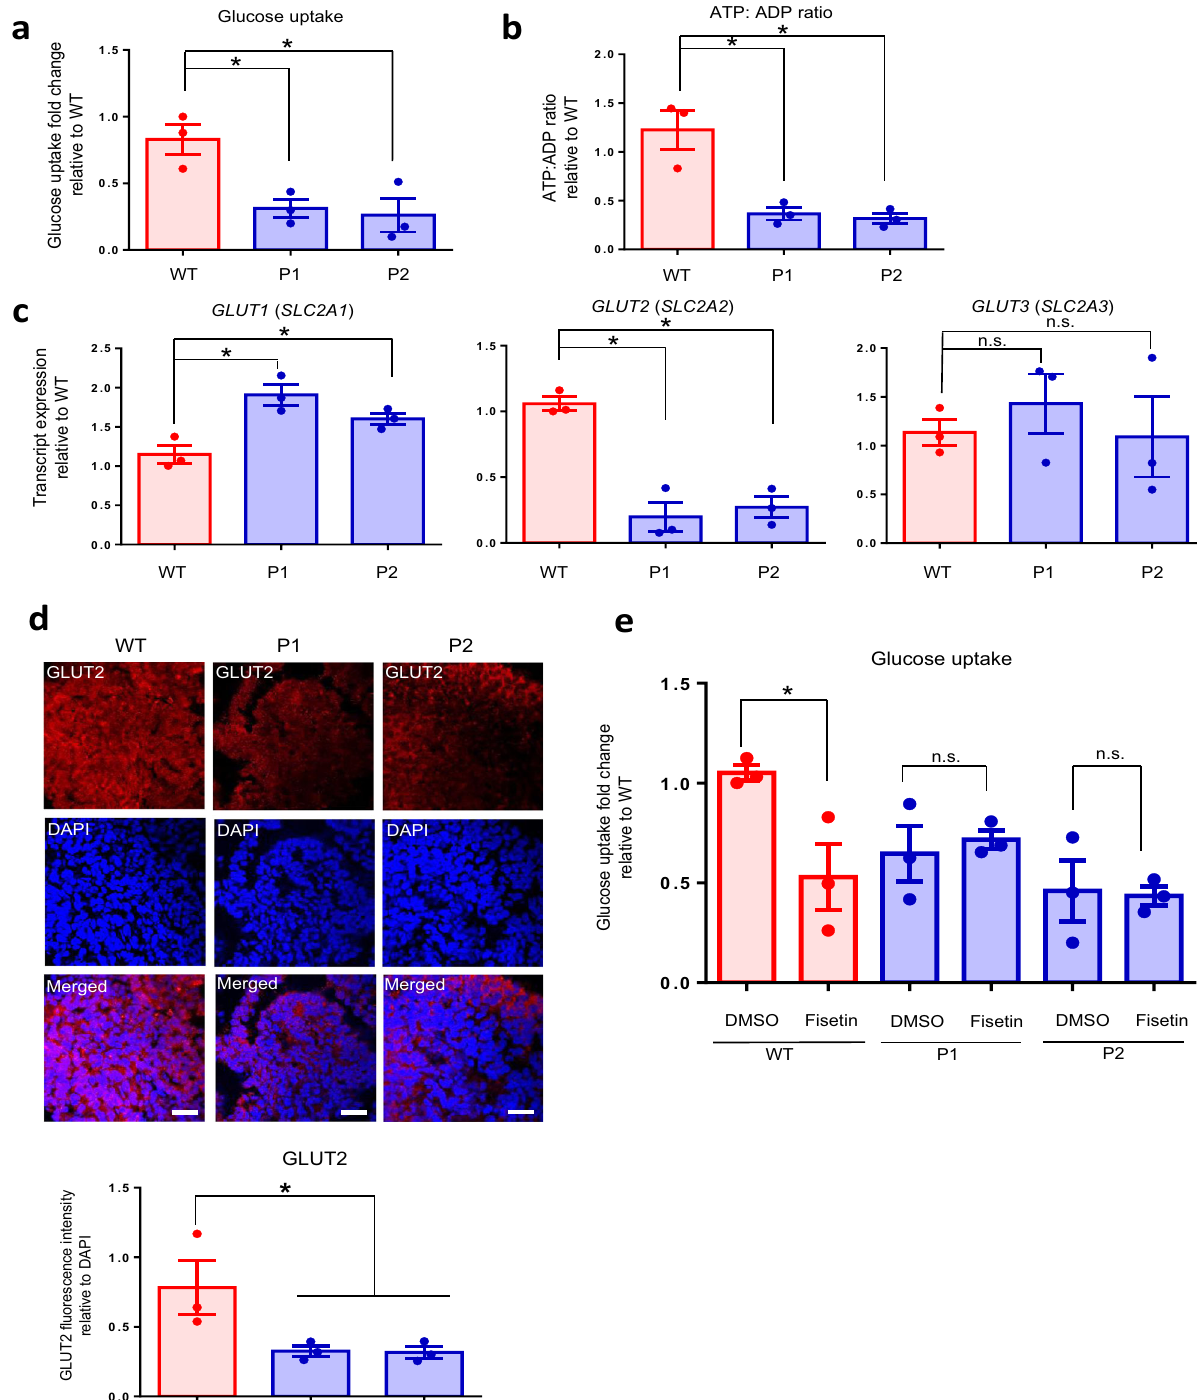
simple interrupted pattern. After surgery, animals were observed until they can maintain sternal recumbency. Before being returned to the housing area, 0.1 mg/kg buprenorphine, SQ, was given on the opposite side from the incision or between the shoulder blades. Wound clips or remaining skin sutures were removed 7 – 14 days after placement. Glucose uptake assay . Approximately 100 hPSC-derived β -like cells were picked into each well of a 12-well cell culture plate and rinsed three times with PBS.